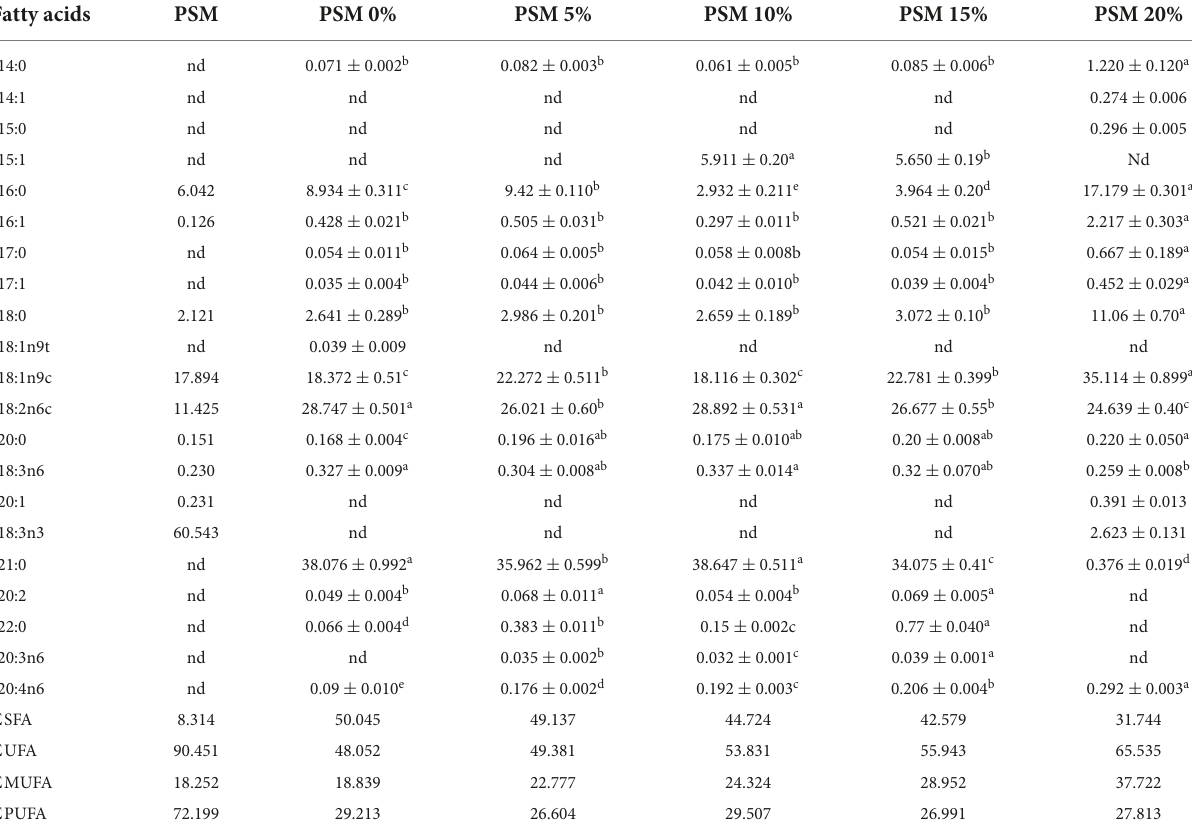
TABLE 3 Fatty acid composition (%) of PSM and pan-fried chicken patties incorporated with different levels of Perilla seed meal (PSM). Fatty